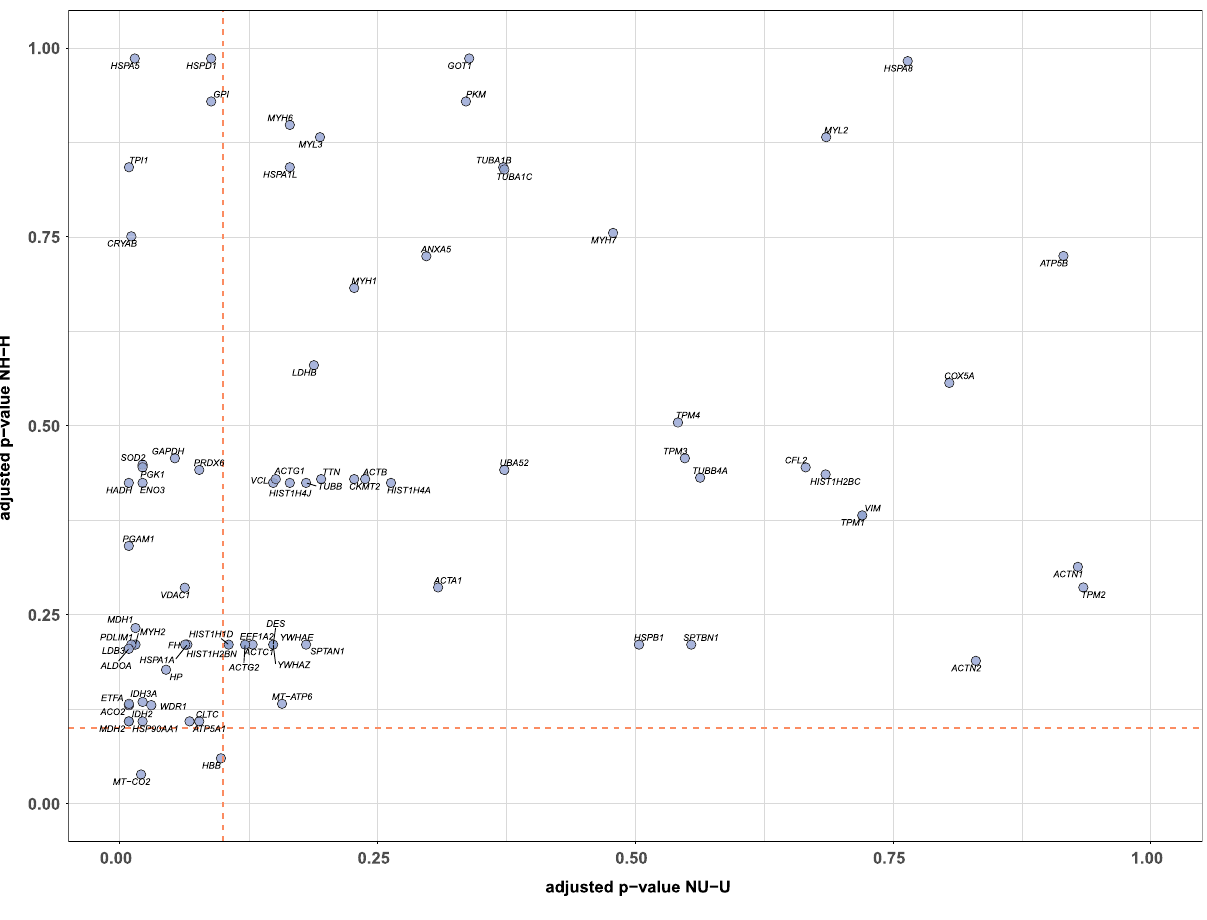
Figure 3. Degrees analysis. The bubble plot shows the adjusted p-values that were computed to obtain SSPs for both comparisons, i.e. NH-H and NU-U. All the 79 proteins in the master network are reported. The pink, dashed lines represent the adjusted p-value threshold with FDR < 0.1 . Notably, 2 proteins fell below the horizontal, pink dashed threshold, i.e. H-SSPs for NH-H comparison, while 32 proteins fell below the vertical, pink dashed threshold, i.e. U-SSPs for NU-U comparison. The proteins in the bottom left corner were found to be significant for both comparisons.